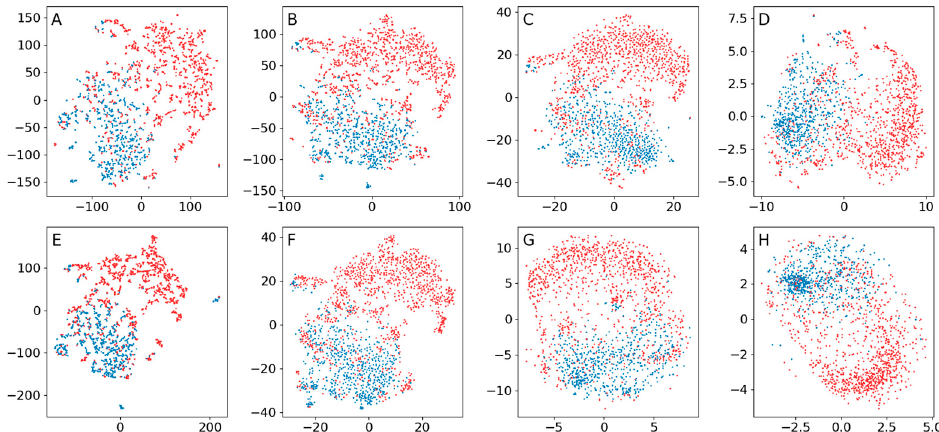
Figure A3. Comparison of the original t-SNE performed with the suggested distribution or a normal distribution. The data are short-time Fourier transform representations of an EEG representing status epilepticus, where each dot is 1 s and red dots indicate seizure activity. First row ( A – D ): using a normal distribution. Second row ( E – H ): using the suggested distribution. ( A ) Perplexity 0.25%; ( B ) perplexity 1%; ( C ) perplexity 5%; ( D ) perplexity 20%; ( E ) 0.25% neighbors; ( F ) 1% neighbors; ( G ) 5% neighbors; ( H ) 20% neighbors.